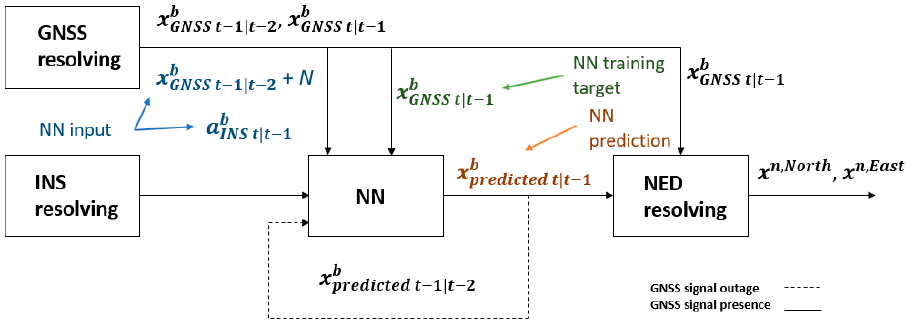
Figure 1. Training set-up of the proposed displacement estimation model.